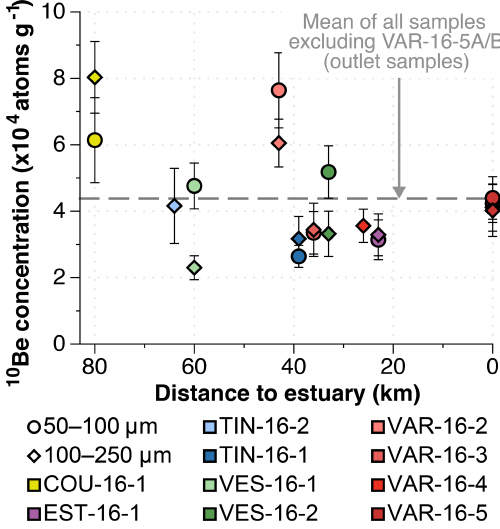
Figure 2. 10 Be concentrations in quartz from river sands of the Var basin plotted against the distance to the estuary (km). Data are available in Table 1. Symbol shape reflects the analyzed grain size and colors indicate the subbasin. The dashed line corresponds to the mean concentration of all samples, excluding the four outlet sam- ples. Error bars represent 1 σ